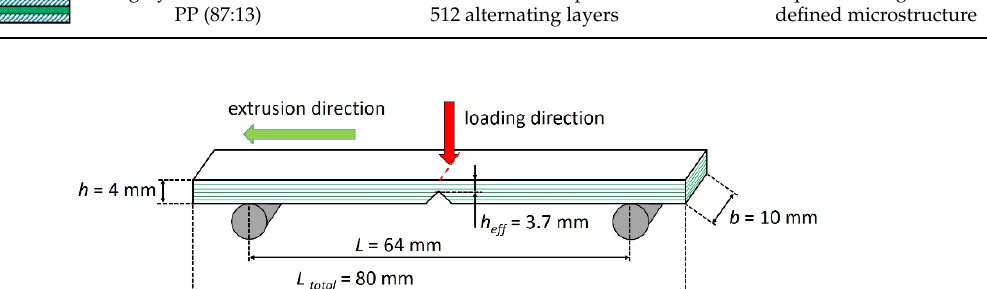
Figure 1. Charpy specimen dimensions with the notch introduced flatwise.